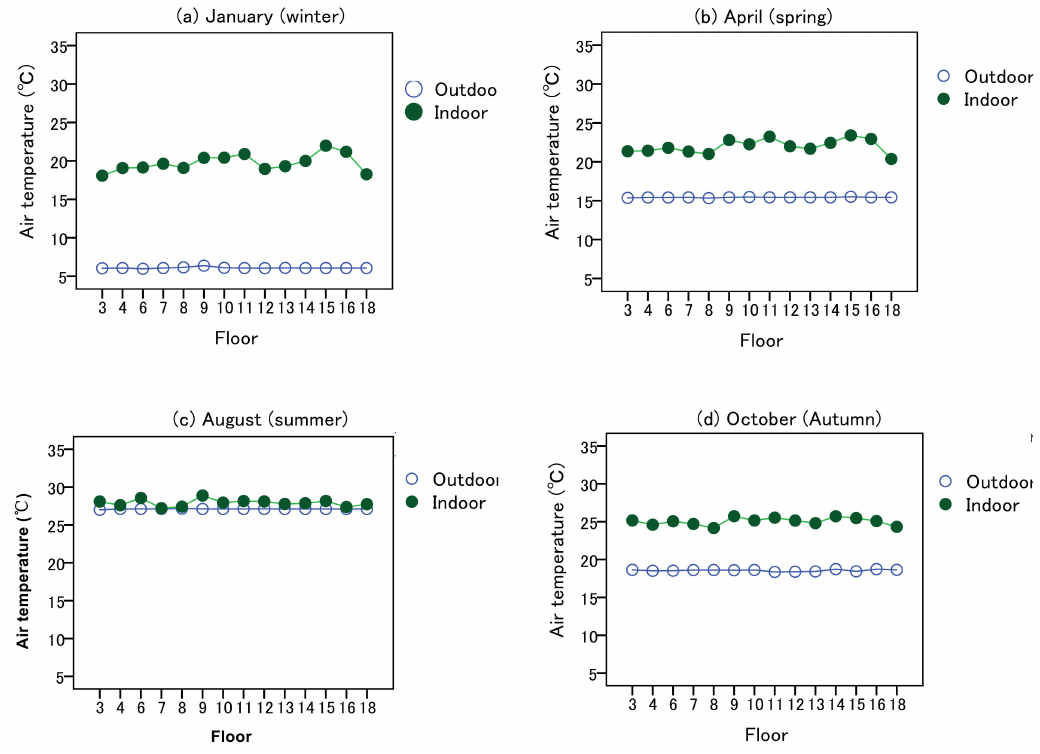
Figure 7. Indoor air temperature representative months of all seasons: ( a ) Winter, ( b ) Spring, ( c ) Summer, ( d )